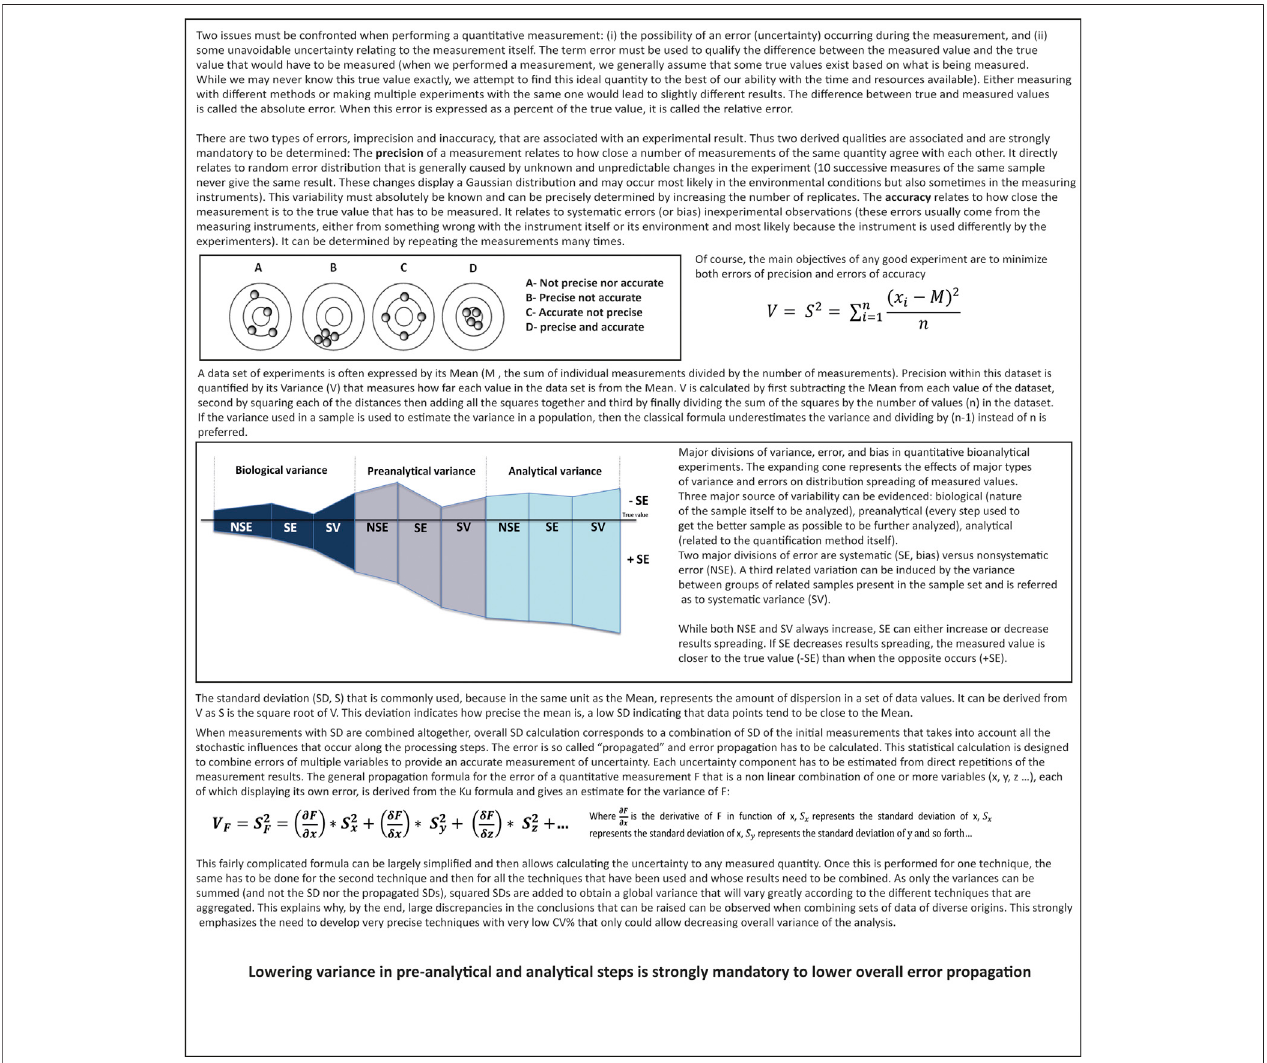
FIGURE 1 | Error de fi nitions and